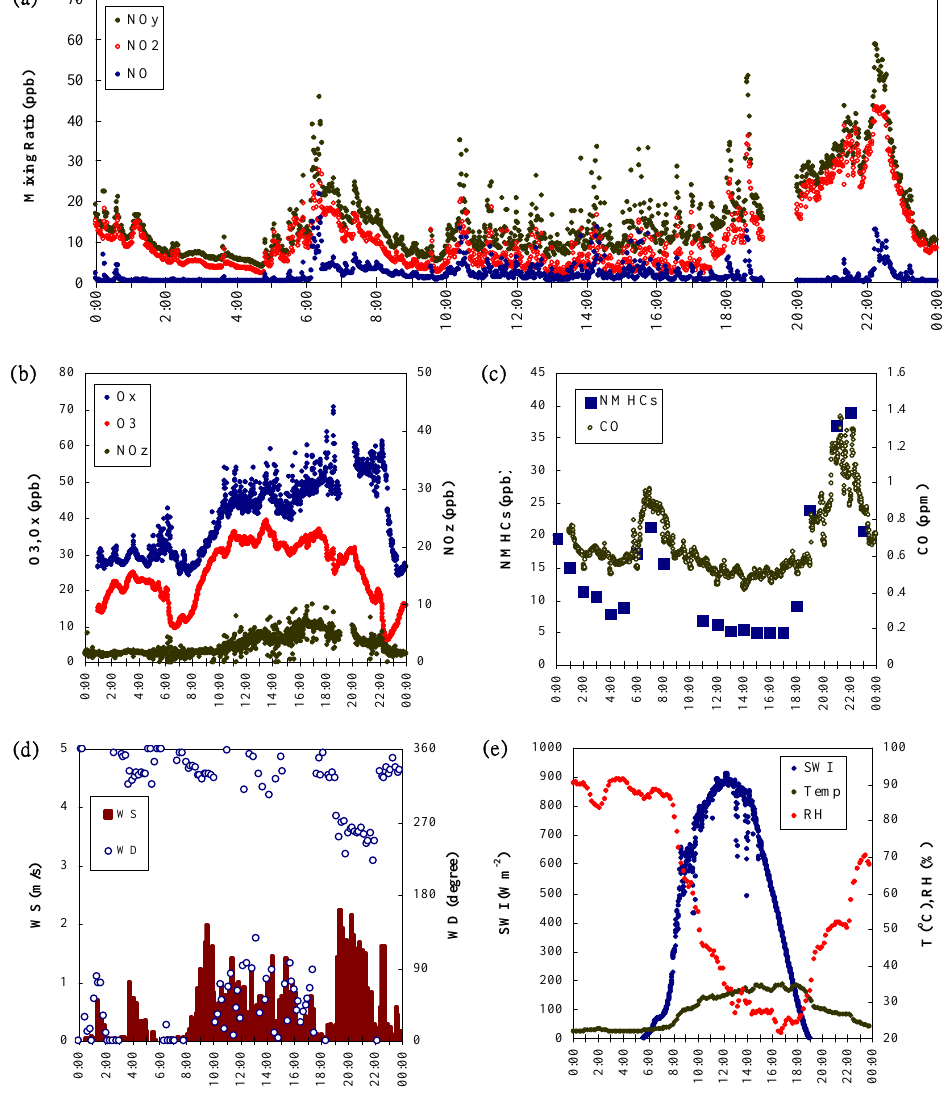
Fig. 7. Same as Fig. 3 but for 15 August